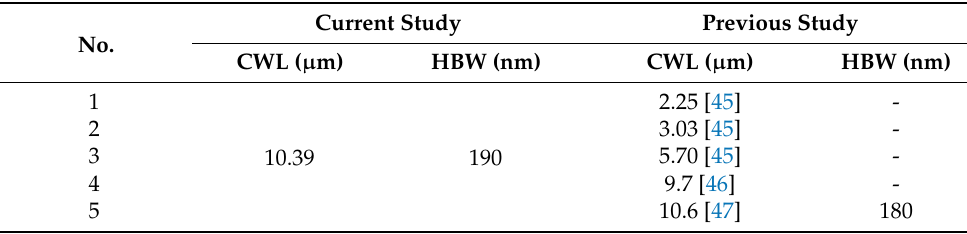
Table 3. Information on NH 3 BPF from previous and current